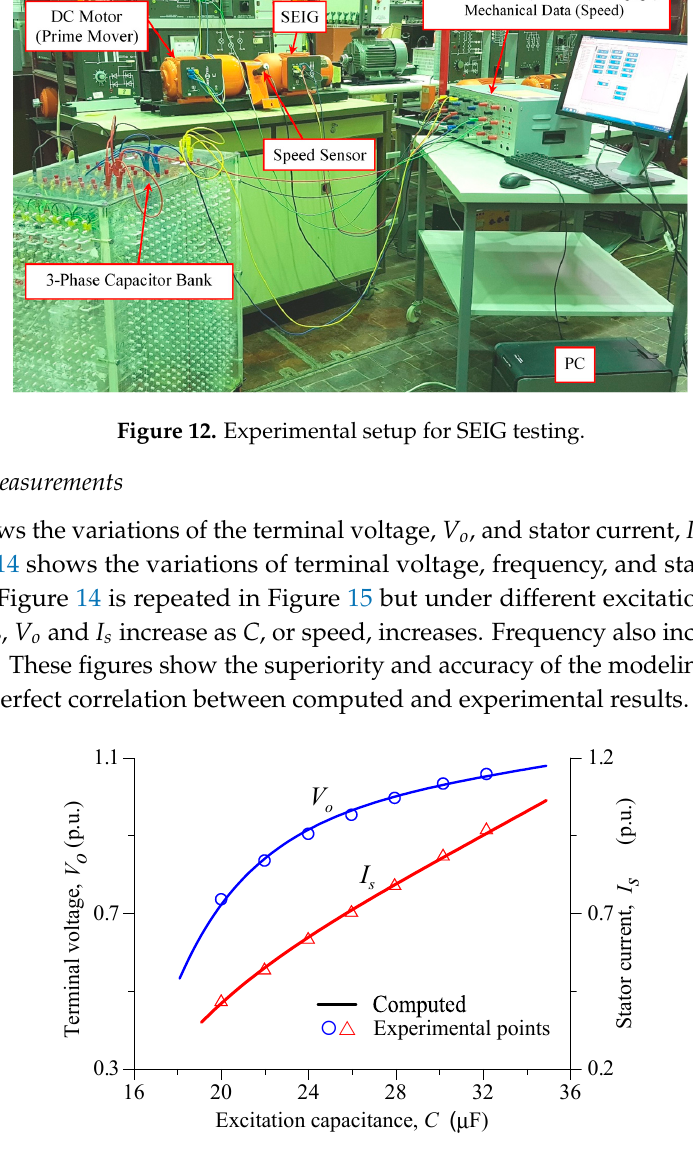
Figure 13. Terminal voltage V o and stator current I s versus excitation capacitance C under no load when speed ( u ) = 1